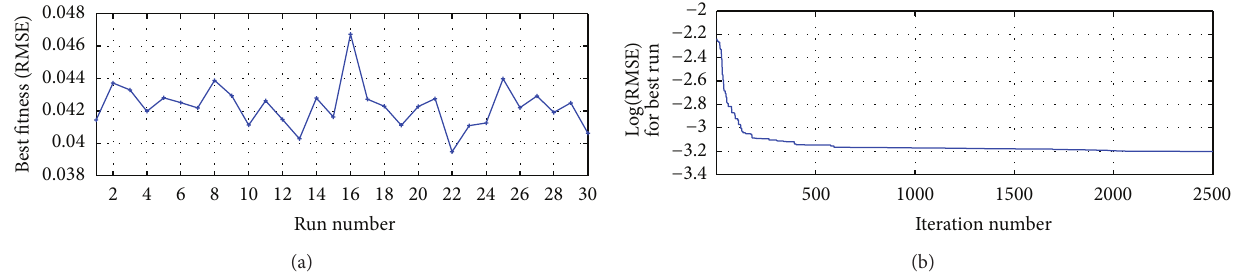
Figure 12: HSVD-ANN-PSO(9,11,1): (a) run versus fitness for 2500 iterations and (b) iterations number for the best run.